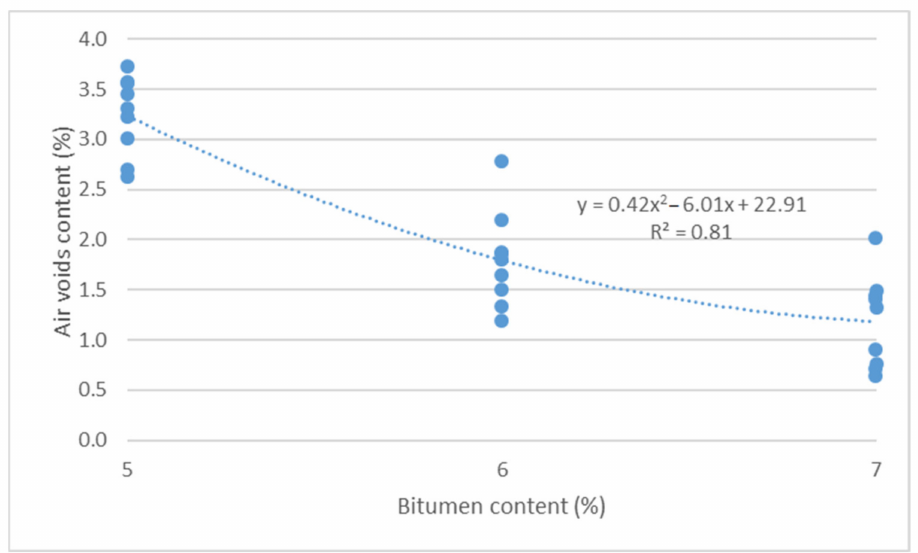
Figure 11. Air void content vs. bitumen content.